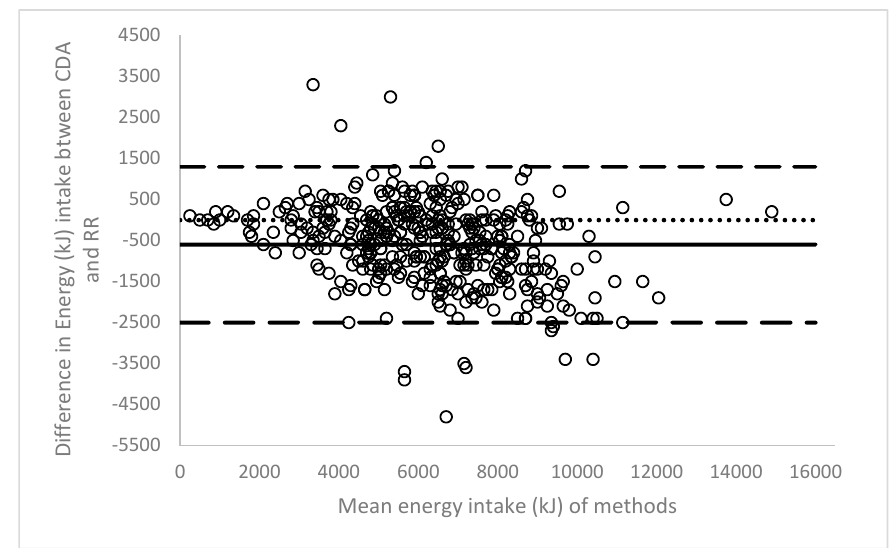
Figure 2. Bland-Altman plot of energy intake calculated using computerised dietary analysis (CDA) and ready reckoner (RR) analysis ( n = 413).